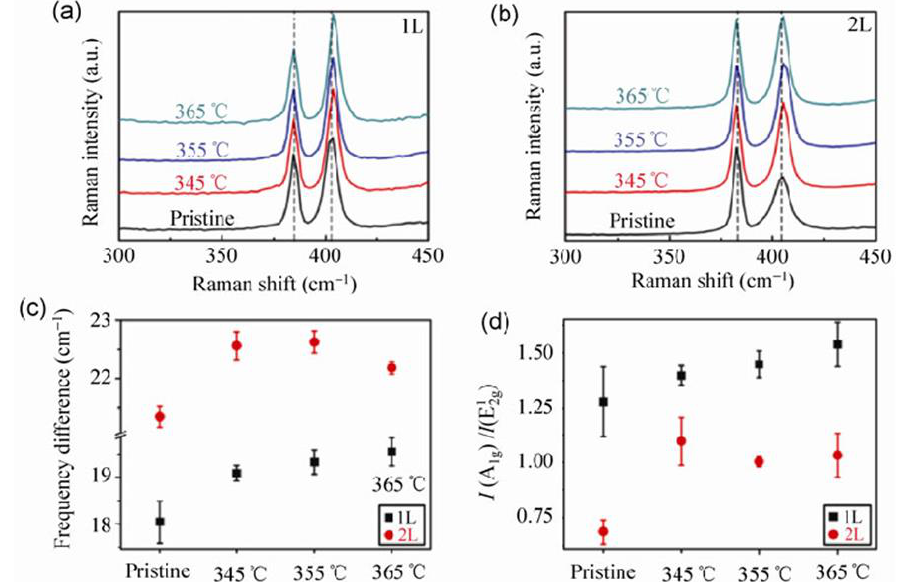
Figure 9. ( a , b ) Comparison of the Raman spectra of 1L and 2L MoS 2 heated in air at different temperatures. ( c , d ) The corresponding frequency differences (frequency of the A 1g mode minus frequency of the E 12g mode) and intensity ratios (A 1g mode to E 12g mode) for 1L (black) and 2L (red) MoS 2 . Increasing ratio of the intensities in ( d ) corresponds to decreasing ratio of the linewidths. Reprinted by permission from Springer Nature Customer Service Centre GmbH: Springer Nature, Nano Research [33] (2013).